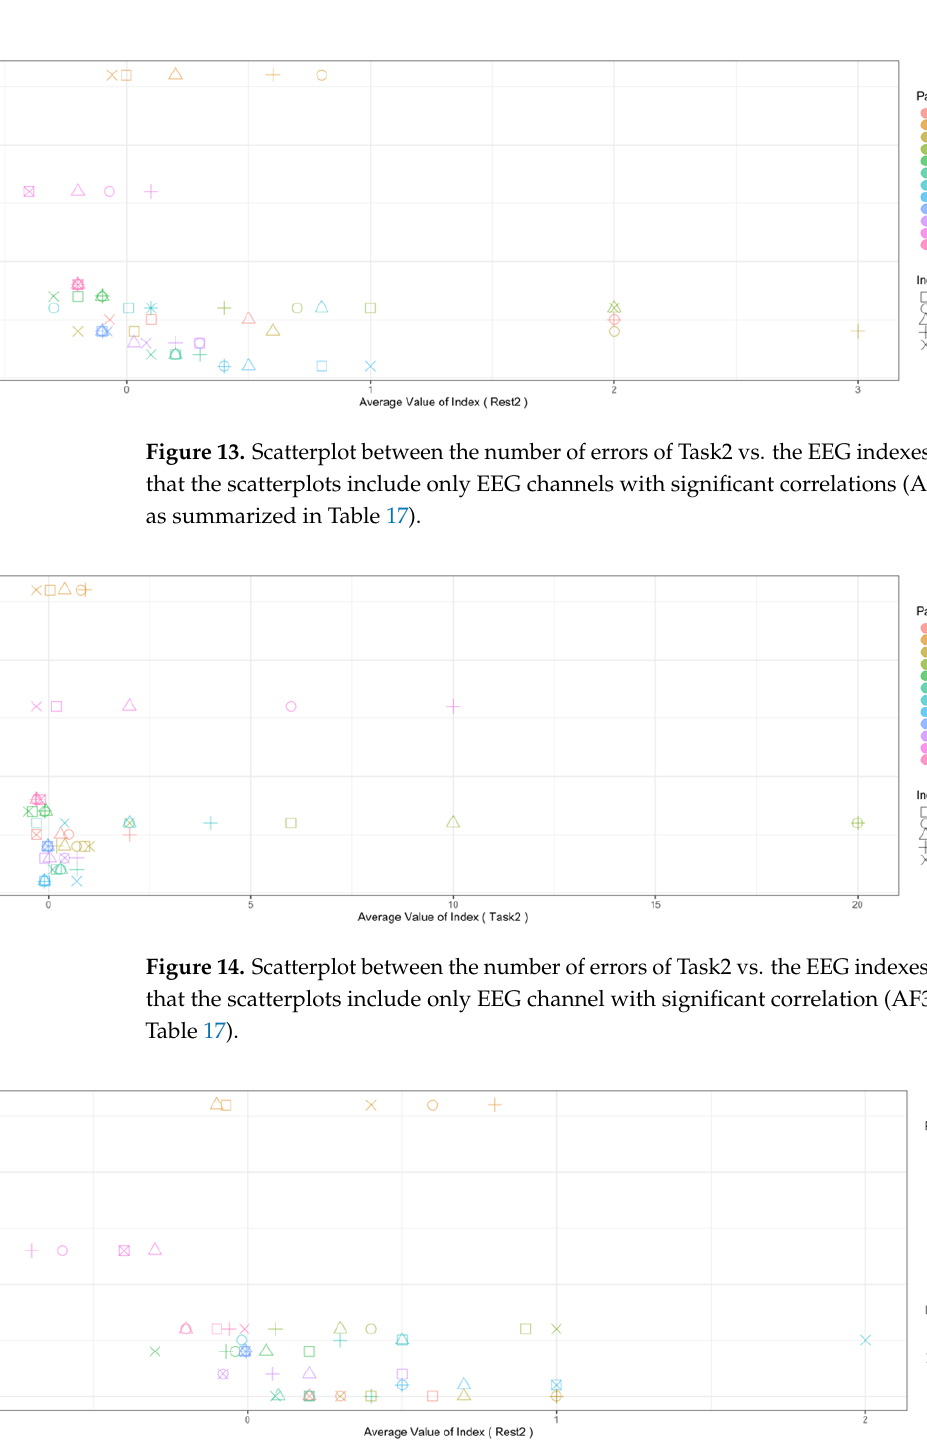
Figure 15. Scatterplot between the number of errors of Task2 vs. the EEG indexes during Rest2. (Note that the scatterplots include only the EEG channel with a significant correlation (P8), as summarized in Table 17).